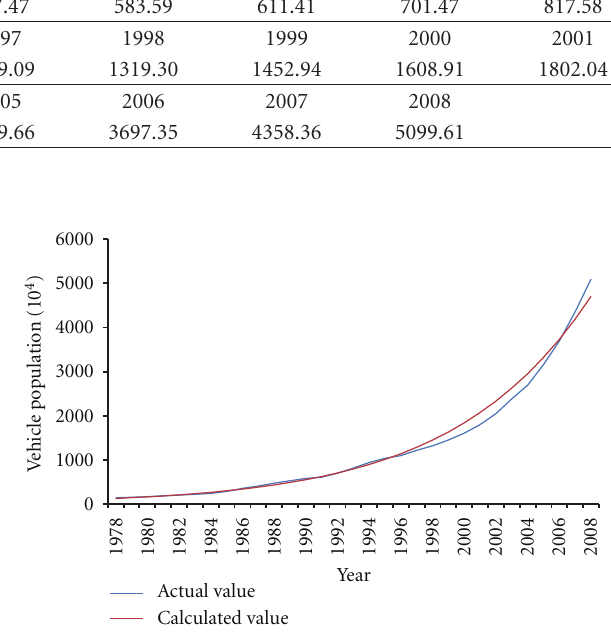
Figure 2: Comparison of calculated vehicle population and actual